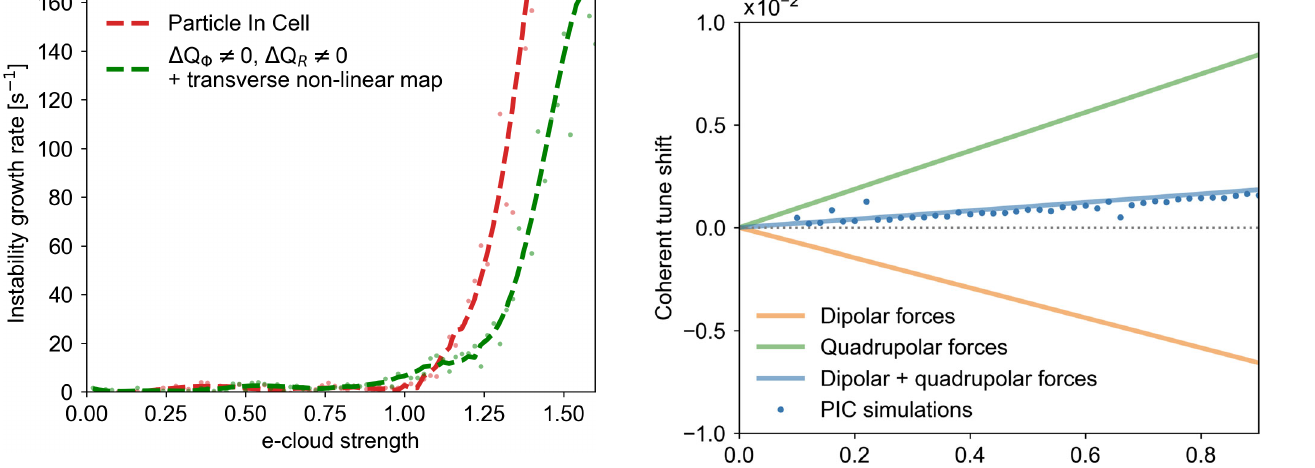
FIG. 11. Dots: Instability growth rate obtained by macroparticle simulations with the PIC method (in red), and with the linearized model and a static non-linear map to model the e-cloud transverse nonlinearities (in green). Dashed lines: smoothed version of the data represented by the dots.